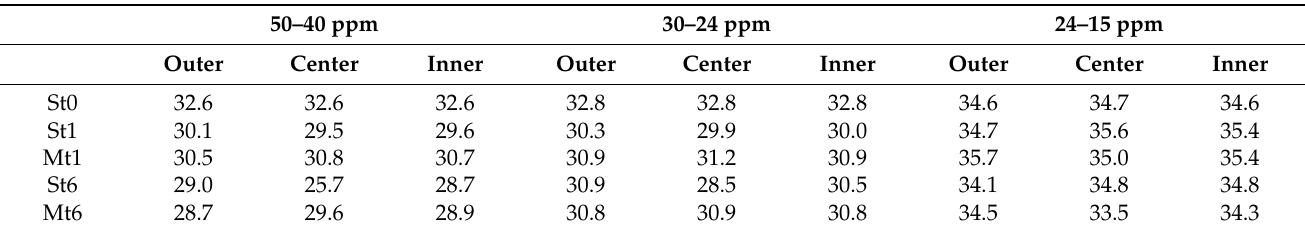
Table 5. Remaining Ct mask (%) in C-types of PP of the outer, center and inner layer of single-use face masks incubated with topsoil either as cuts of single layers (S) or of complete masks (M) for 1 and 6 months (t1; t6) under the controlled conditions of a microcosm experiment. The numbers were calculated from the mean values of the relative intensity in the chemical shift regions of the CPMAS 13 C NMR spectra of the undegraded mask layers (St0) and the C loss determined by CO during incubation (Table